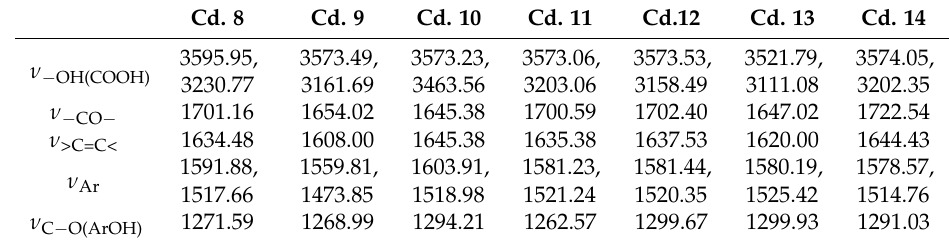
Table 4. The IR data of Cds. 8 – 14 (KBr pellets, ν max , cm − 1 ).